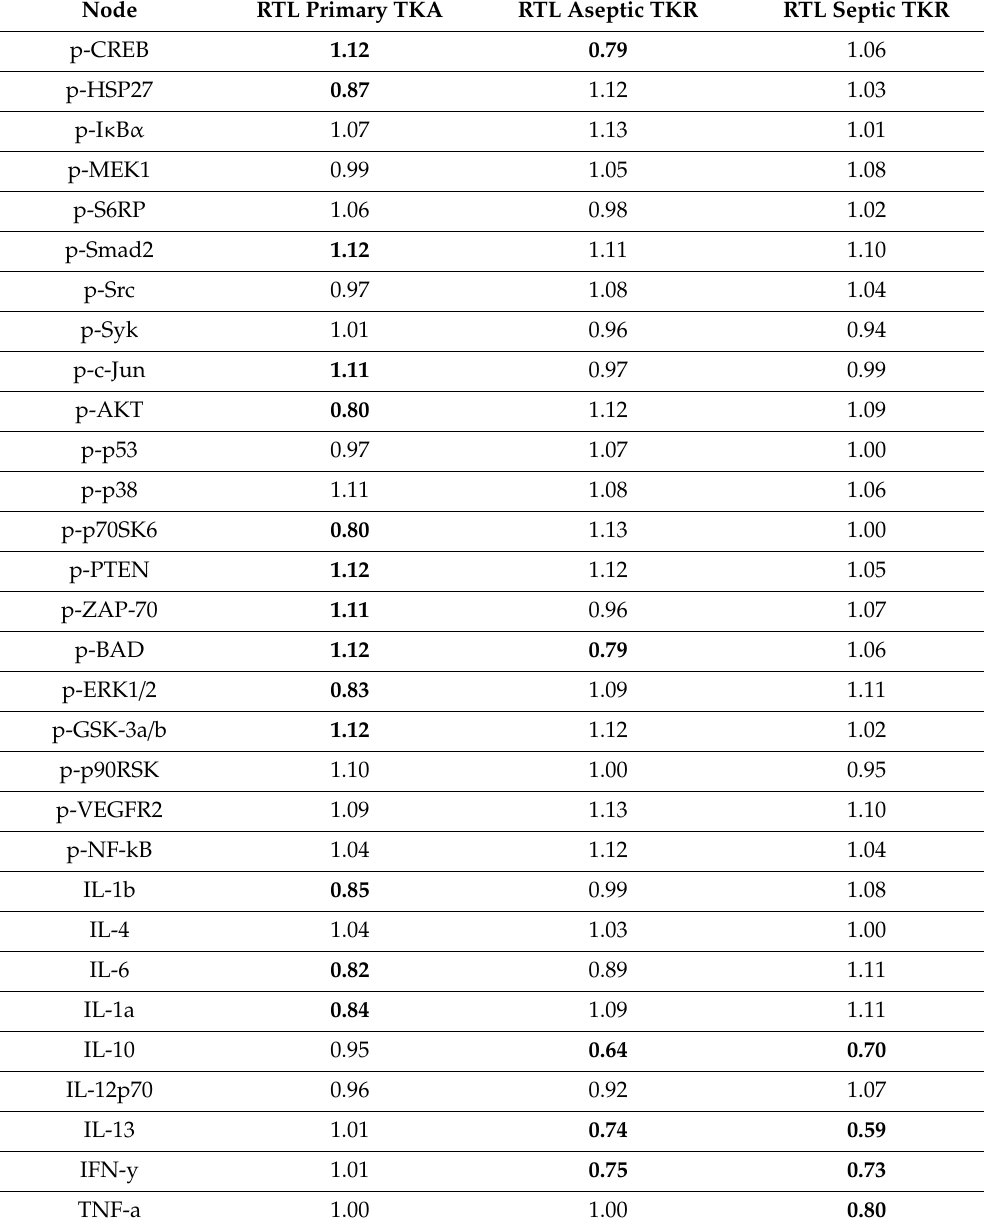
Table 5. Normalized Radiality of Nodes in the RTL Layer. Significant target values for each individual network are bolded (significance threshold: the average radiality ± standard